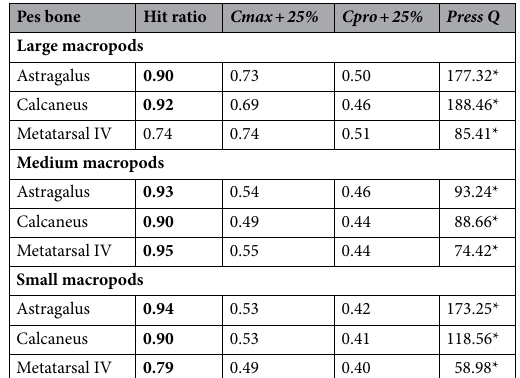
Table 1. Cross validated hit ratios for each skeletal element. Bold indicates a correct reclassification probability that exceeds the thresholds for all three test criteria. *Significant at p = 0.1.